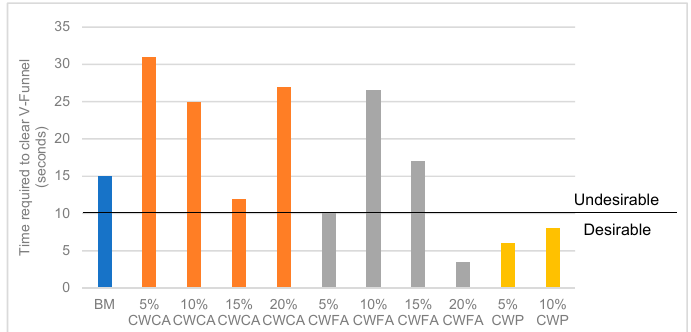
Figure 6. The time taken for SCC samples containing varying doses of CWCA, CWFA, and CWP to pass through a V-Funnel.